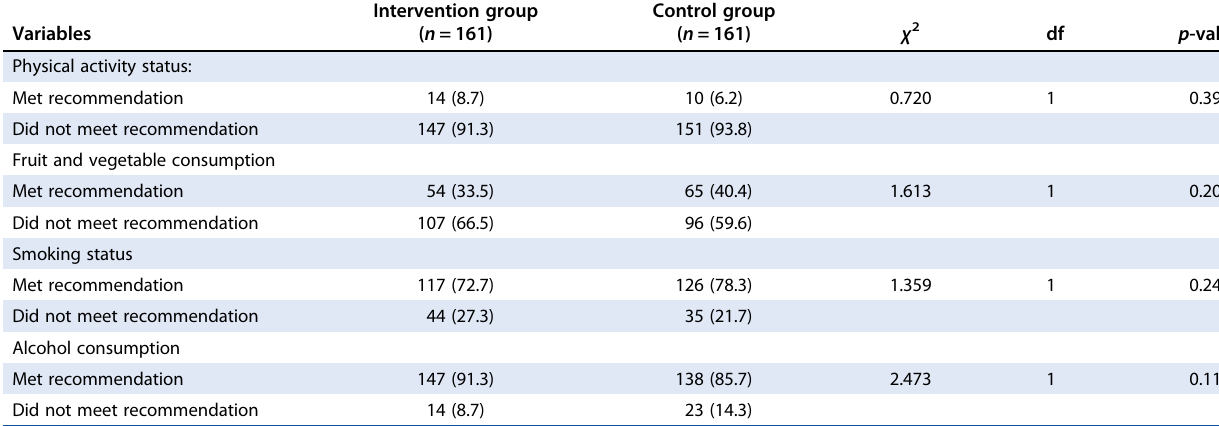
Table 2: Pattern of lifestyle behaviours of respondents pre-intervention